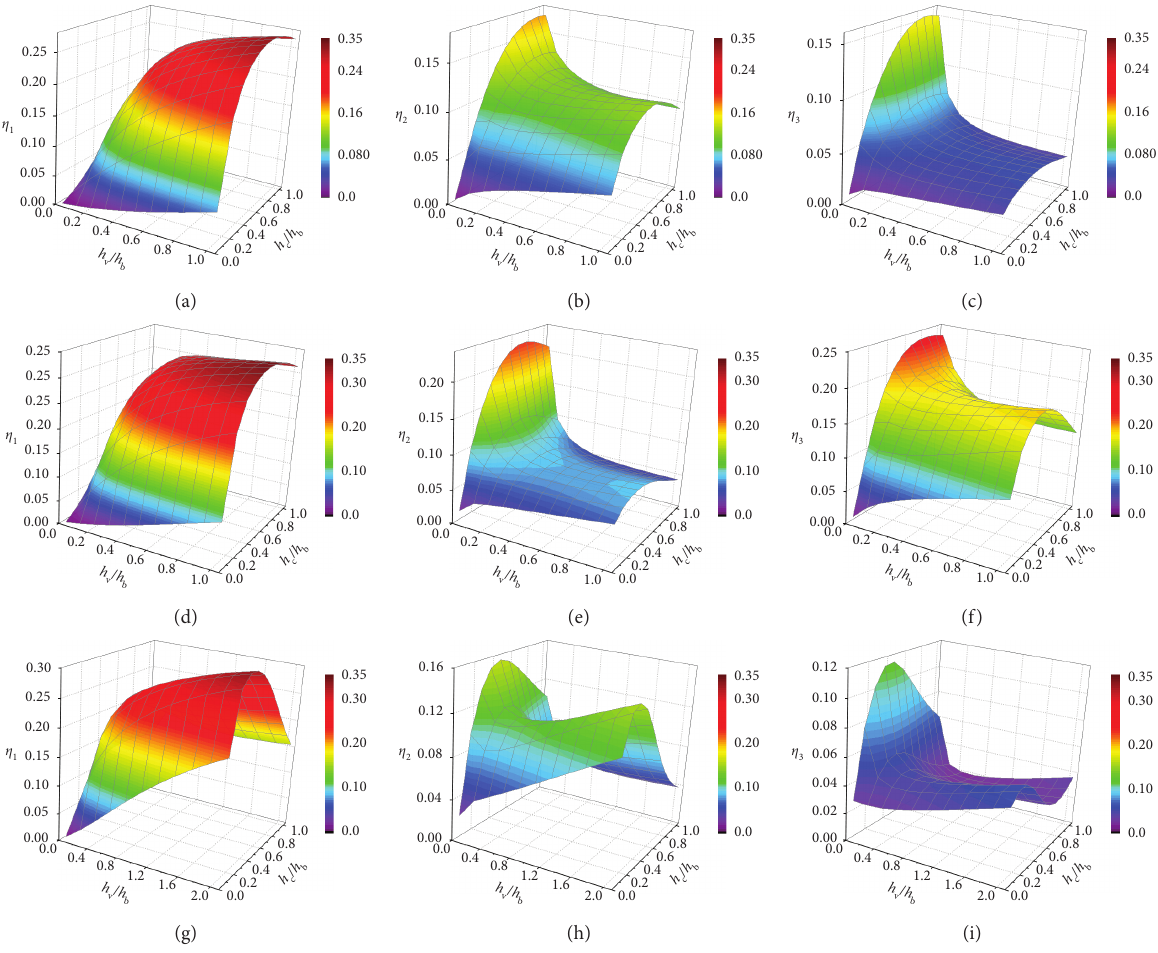
Figure 6: The parameter effects on the first three modal loss factors. (a) Mode 1 for structure 1. (b) Mode 2 for structure 1. (c) Mode 3 for structure 1. (d) Mode 1 for structure 2. (e) Mode 2 for structure 2. (f) Mode 3 for structure 2. (g) Mode 1 for structure 3. (h) Mode 2 for structure 3. (i) Mode 3 for structure